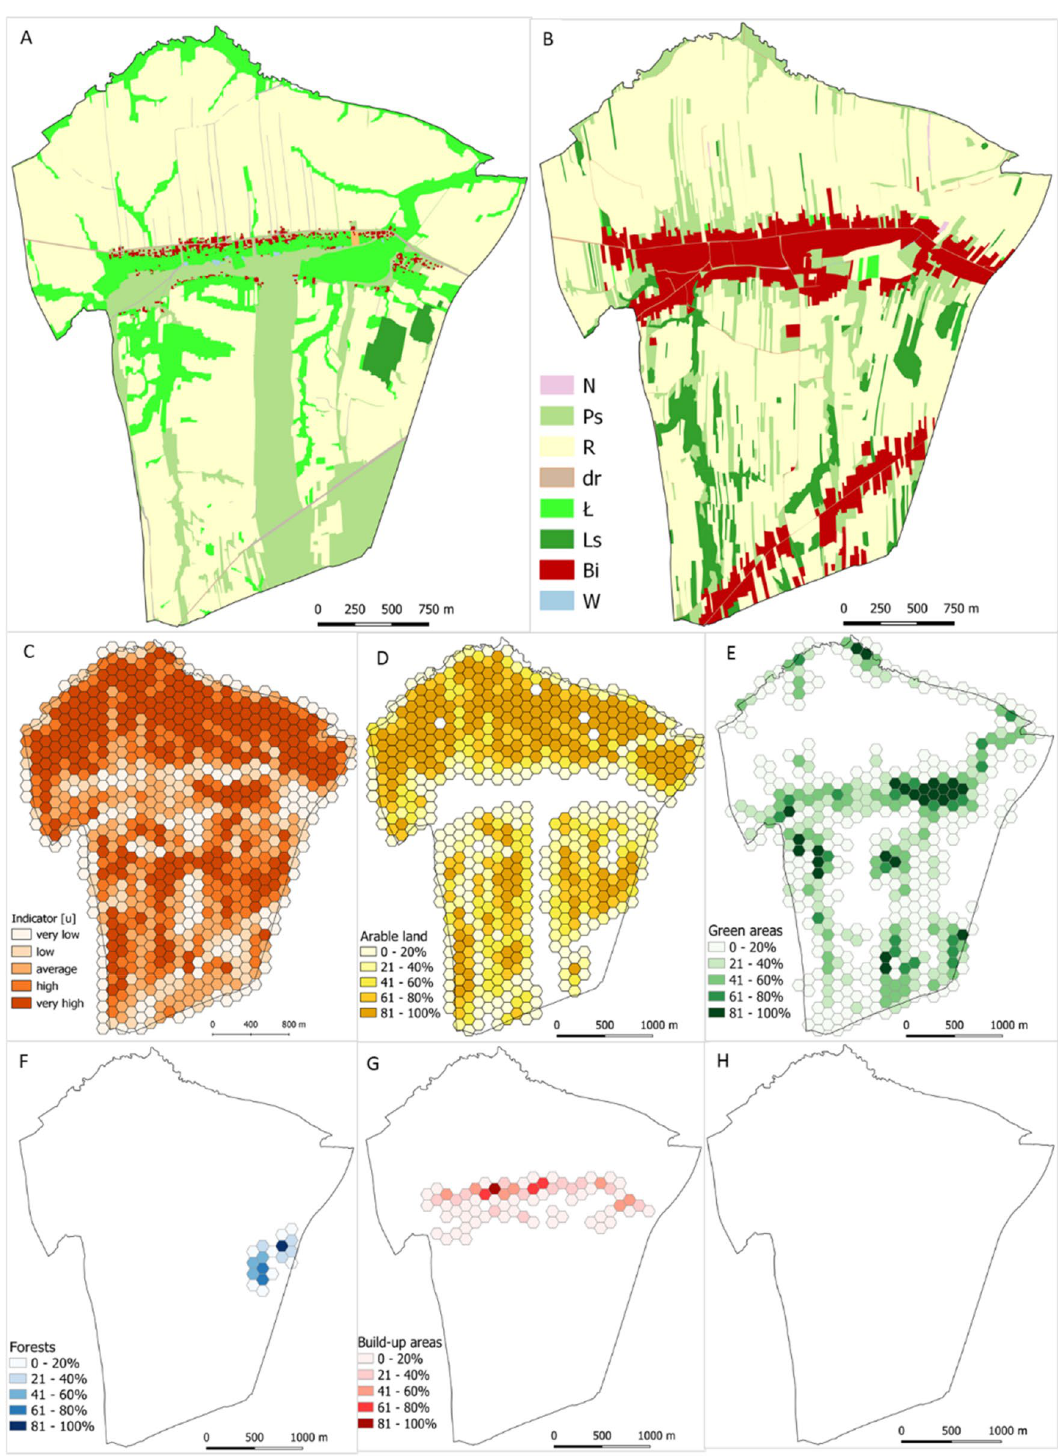
Figure 4. Stages of the spatial assessment of land-use (land-cover types) structure persistence analysis. ( A ) Land use structure in the start time t 0 ; ( B ) Land use structure in the end time t 1 ; ( C ) Land-use structure persistence index u spatial distribution; ( D ) persistence of arable land; ( E ) persistence of grassland; ( F ) persistence of forests; ( G ) persistence of built-up areas; ( H ) persistence of